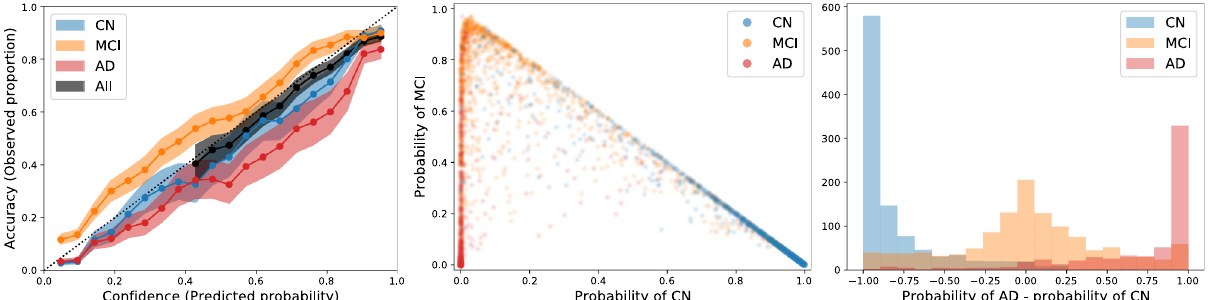
Figure 4. Clinical predictions in the leave-one-site-out cross-validation experiment on the whole ADNI dataset. For each left-out subject, a prediction was estimated at each diagnosis assessment time after the first two years of follow-up. Left: Calibration estimation. The dots represent the mean (shaded areas the 95% CI) of the confidence- (black) and classwise-reliability diagrams (coloured). Centre: Simplex plot illustrating the mean predicted probability assigned to each observation (e.g., the probability corresponding to the points lying on the bottom-left corner is 100% AD, 0% MCI and 0% CN). The dot colour indicates the ground truth label. Right: Histograms of the predicted AD probability minus the CN probability for each ground truth clinical label.